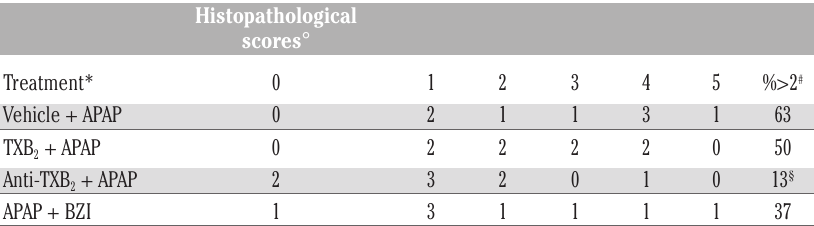
, anti-TXB and BZI on APAP-induced liver injury. 2 2 Histopathological scores°